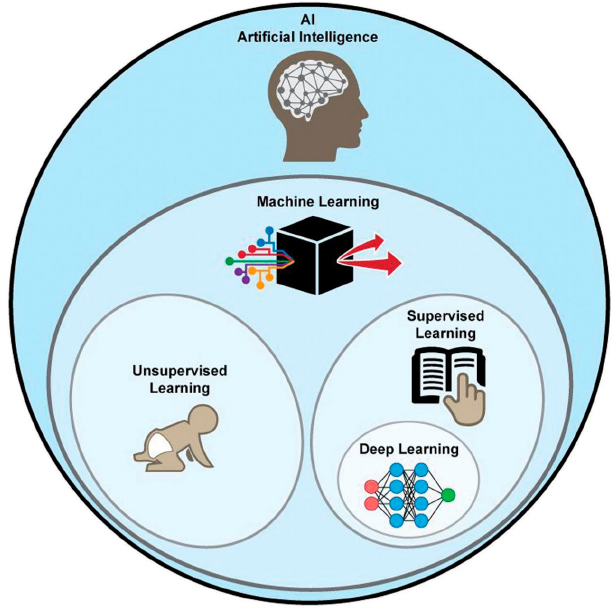
Figure 15. Graphical representation of AI methods. ML is a form of AI, divided into supervised and unsupervised learning. DL is a form of ML, usually based on supervised learning [160].